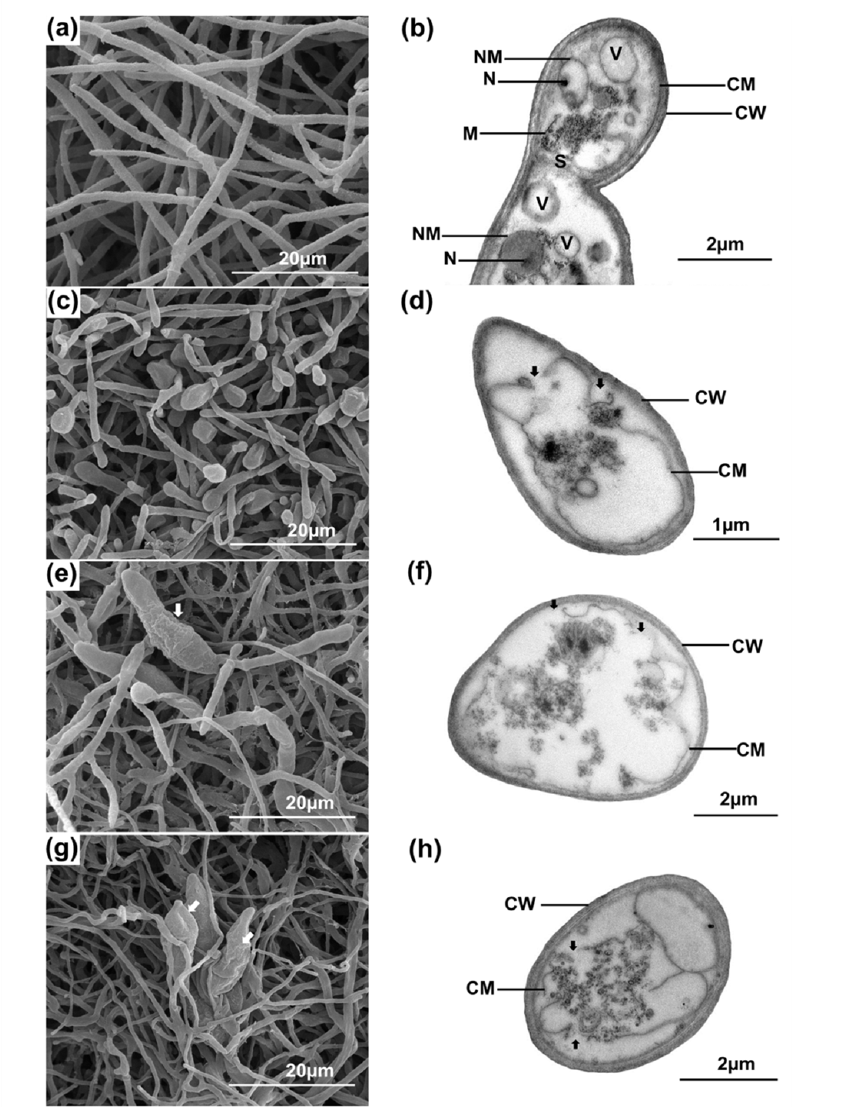
Fig. 1. Scanning electron microscopic (SEM, left) and transmission electron microscopic (TEM, right), images of untreated P. oryzae PTRC1 hyphae (negative control) (a-b), hyphae treated with 32µg/ml (4xMIC) of propiconazole (positive control) (c-d), with 32µg/ml (4xMIC) of AMA49CE (e-f) and hyphae treated with 32µg/ml (4xMIC) of MA49F1 (g-h) after incubation at 25 ± 2°C for three days. CW, cell wall; CM cell membrane; V, vacuole; M, mitochondria; N, nucleous; NM, nuclear membrane; S, septum. White arrows in (e) and (g) indicate the abnormal condia. Black arrows in (d), (f) and (h) indicate the cell membrane